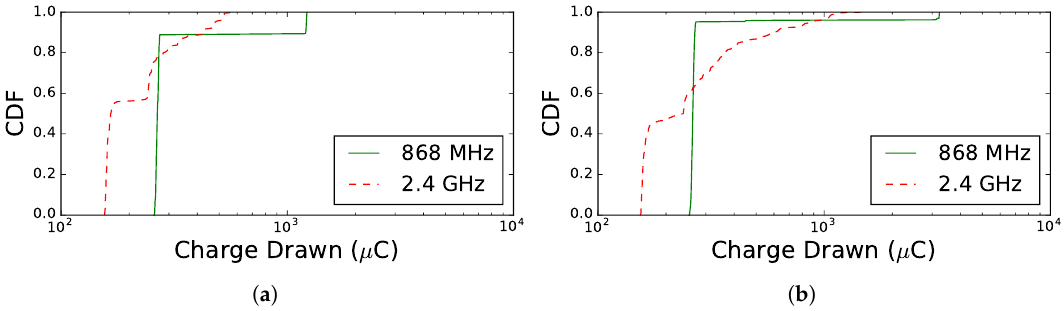
Figure 11. Comparison of charge drawn per cycle per node for 868MHz and 2.4GHz frequency communication in a grid topology of nine nodes and 25 nodes. ( a ) Grid topology of nine nodes; ( b ) grid topology of 25